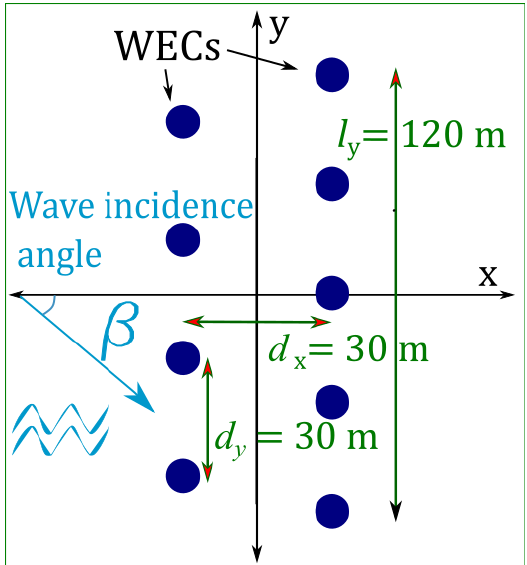
Figure 2. Plan view of the Wave Energy Converter (WEC) array layout for nine heaving buoys. The incident wave makes heading β with the x -axis; d x and d y are the x and y intra-array separation distances; and l y is the length of the array orthogonal to the wave incidence of β = 0 ◦